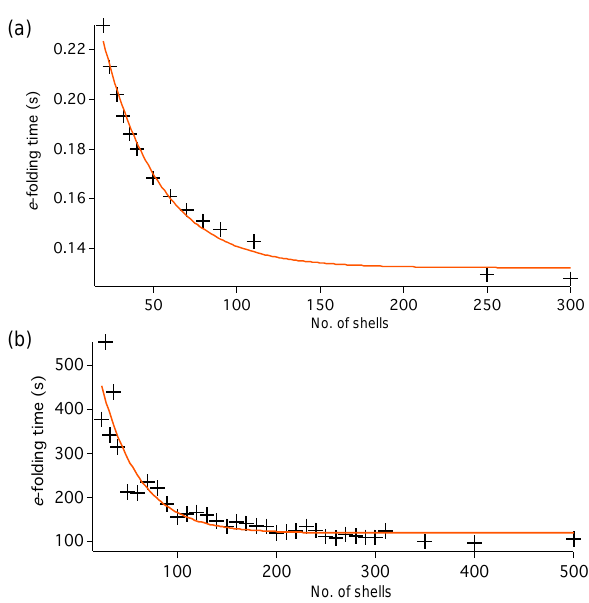
Figure A2. The e -folding time convergence with increasing shell number for the ETH model: change in the semi-volatile component saturation ratio in (a) was 1–90% and in (b) was 90–1%. The self- diffusion coefficient of the semi-volatile was 2.0 × 10 − 9 m 2 s − 1 and that of the non-volatile was 1.0 × 10 − 25 m 2 s − 1 . Orange curves are the exponential best fits.